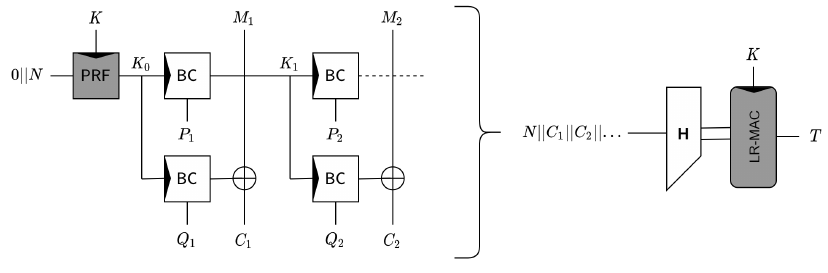
Figure 13: The LR-BC-3 mode of operation.